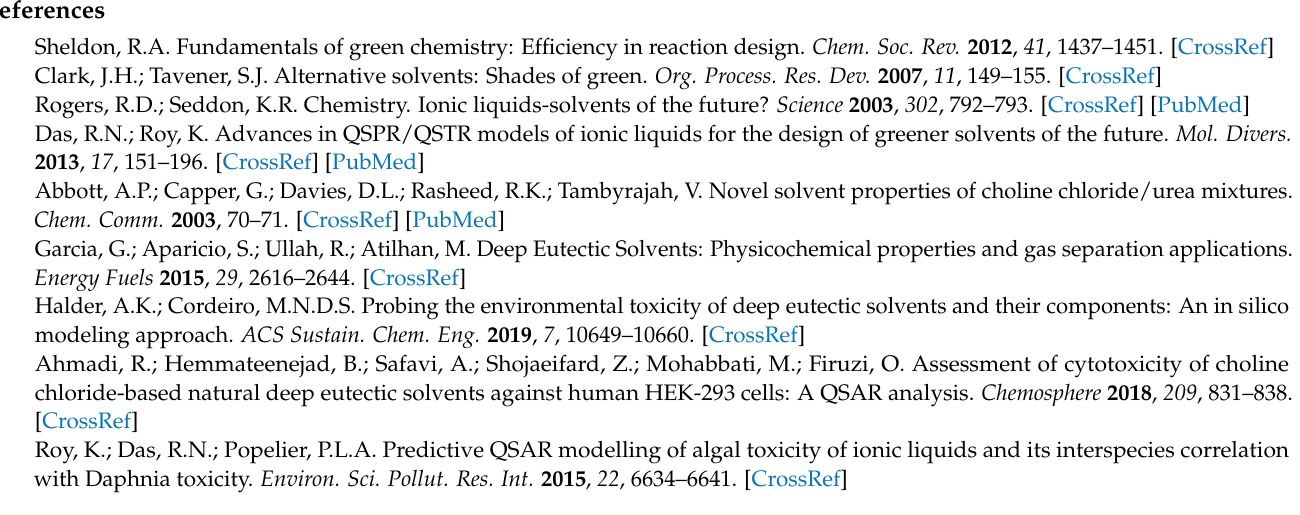
density data; Table S2. Summary of the statistical performance of all CO- and MO-based models; Table S3. Summary of the results for the best model found; Table S4. Detailed results of the consensus prediction; Table S5. Models CO54, MO75 and CO17, derived for DES’ density ( ρ in g/cm 3 ), along with their statistical